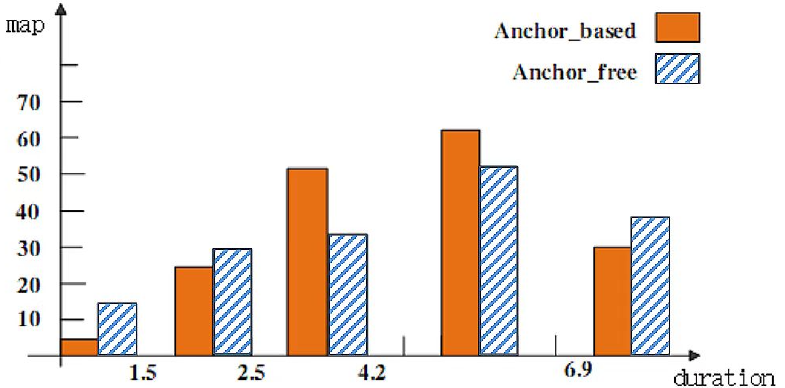
Figure 4. The investigation of a suitable detector for clips of different